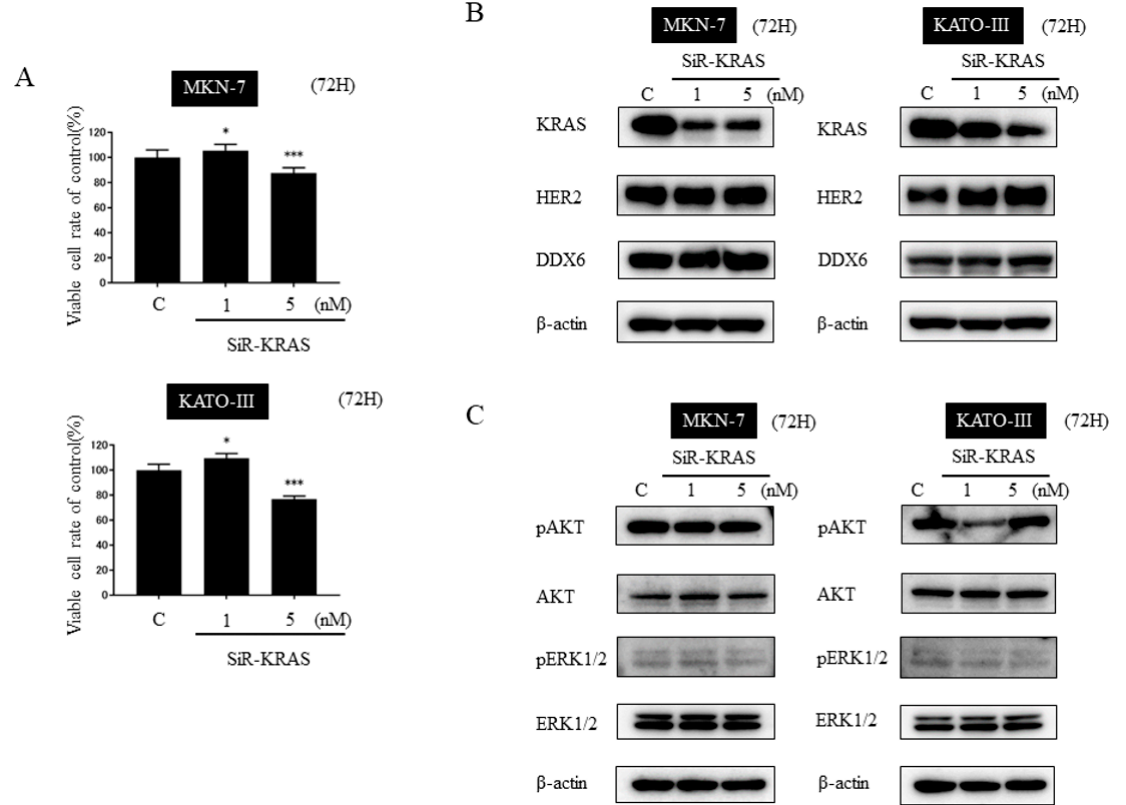
Figure 5. Effects of knockdown of KRAS on cell proliferation and protein expression profiles of KRAS network-related molecules. ( A ) Cell viability at 72 h after transfection of MKN-7 and KATO-III cells with control RNA (5 nM) or siR-KRAS (1 nM, 5 nM). ( B ) Expression levels of KRAS, DDX6, and HER2 at 72 h after transfection of MKN-7 and KATO-III cells with control RNA (5 nM) or siR-DDX6 (1 nM, 5 nM). ( C ) Expression levels of KRAS effector signaling molecules at 72 h after transfection of MKN-7 and KATO-III cells with control RNA (5 nM) or siR-DDX6 (1 nM, 5 nM). Results are presented with the mean ± SD; * p < 0.05, *** p < 0.001.